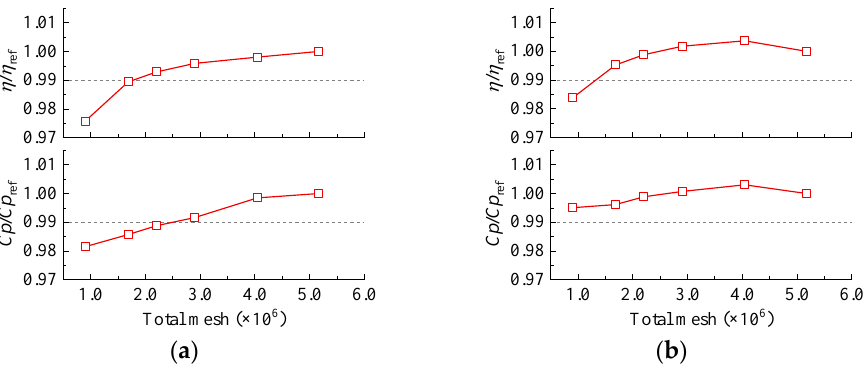
Figure 2. Comparison of stage characteristic for different grid schemes: ( a ) design point; ( b ) near- stall point.